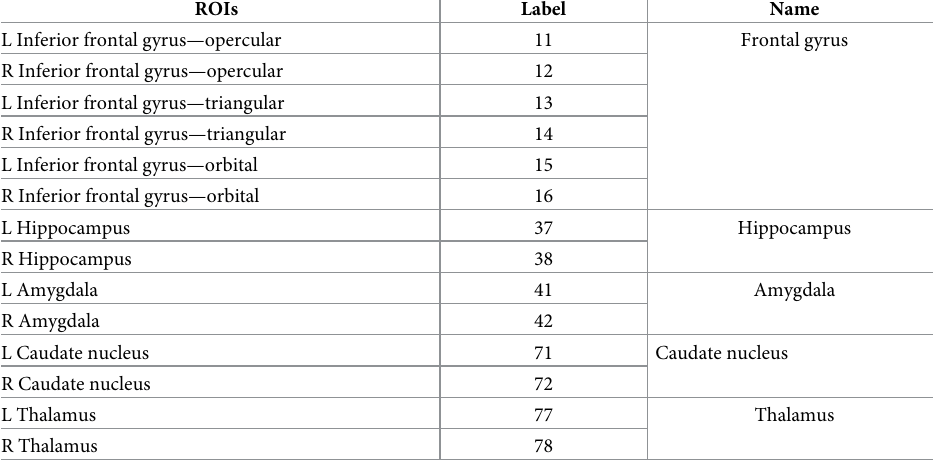
Table 1. The labels and names of the ROIs in the SRI24 space. ROIs Label Name L Inferior frontal gyrus—opercular 11 Frontal gyrus R Inferior frontal gyrus—opercular 12